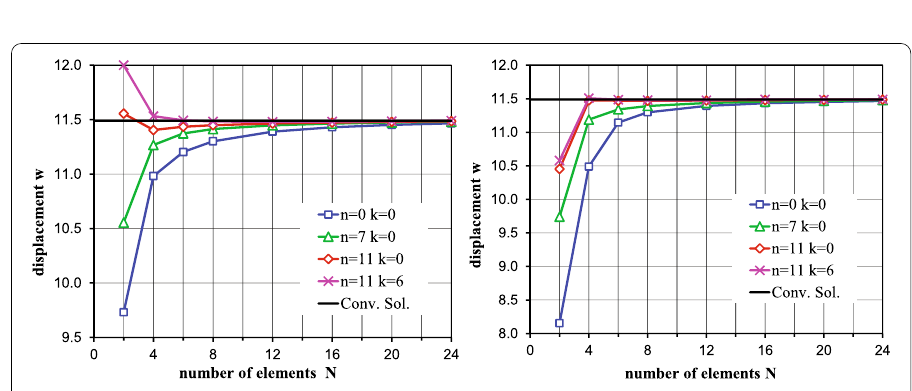
Fig. 35 Annular plate: u zB − N for regular mesh (left) and distorted mesh (right) and p = 1